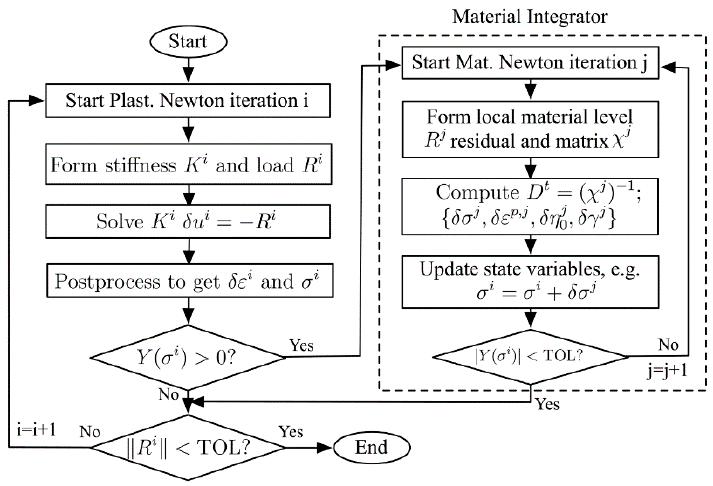
Fig. 4 Flow chart of the extended Newton iteration